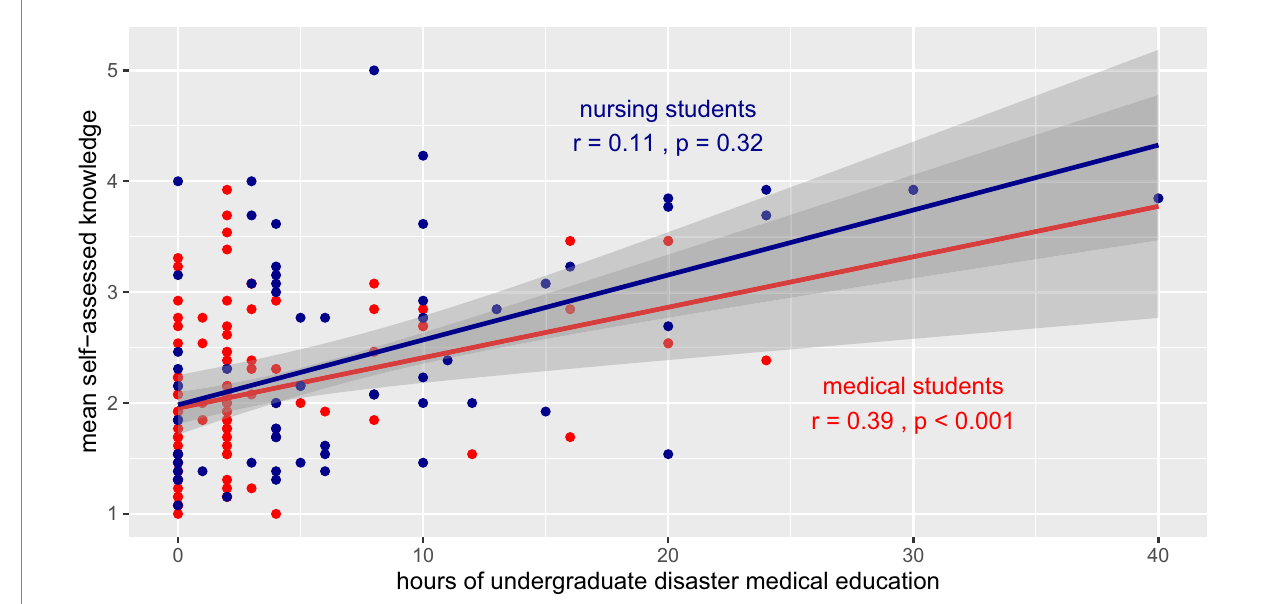
FIGURE 3 Correlation of hours of education and mean self-assessment of disaster medical knowledge among senior medical (red) and nursing (blue) students presented with linear trend